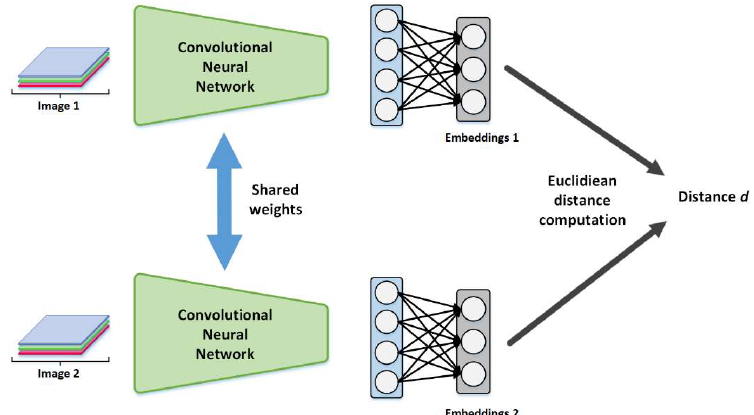
Figure 1. Twin network architecture: CNN backbone and global average pooling operation (green) followed by a series of fully-connected layers (blue) that output the embeddings feature vectors (grey), based on which a distance d between input images can be